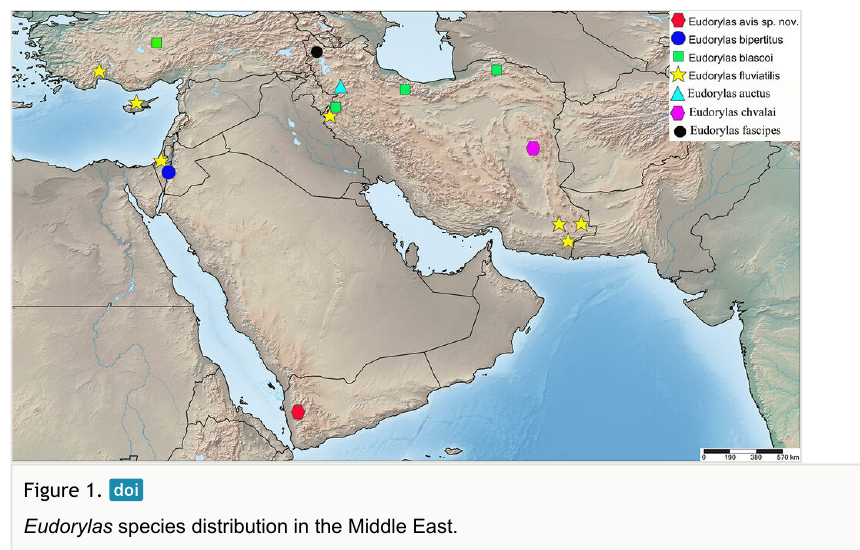
Figure 1. Eudorylas species distribution in the Middle